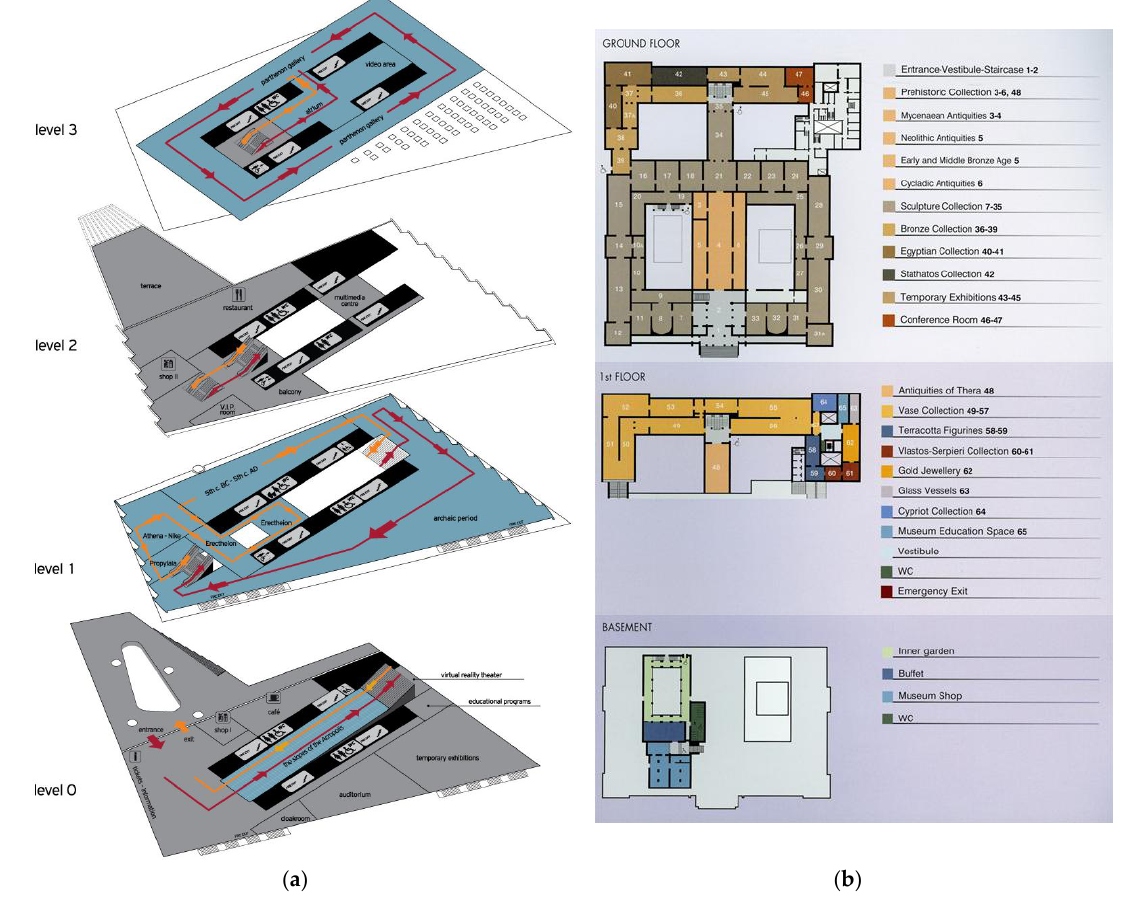
Figure 6. Summary floor plans with exhibition routes ( a ) at the Acropolis Museum; ( b ) at the National and Archaeological Museum. and Archaeological